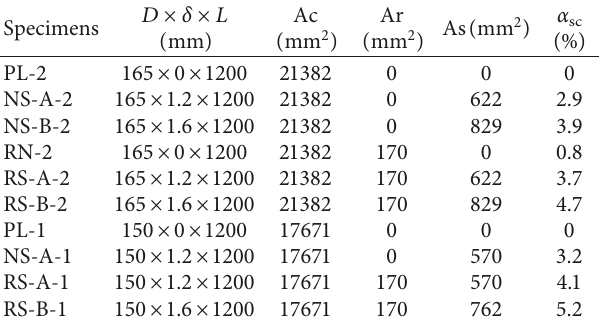
Table 3: Mechanical properties of the concrete and steel tube.